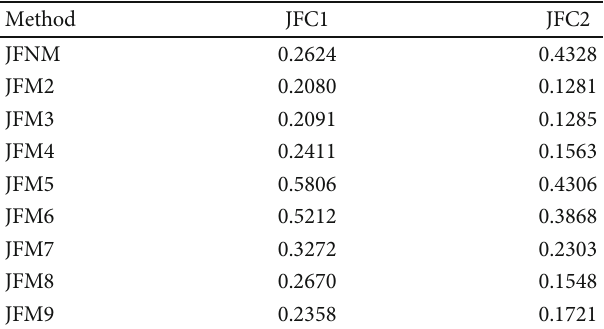
Table 18: Values of JFC1 and JFC2 for methods 1-9 to solve Test Problem 5, by the algorithms of the second category for n = 25 .